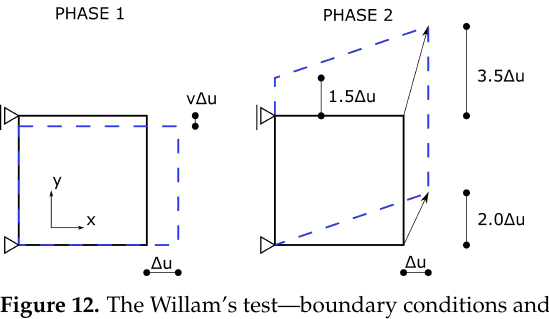
Figure 12. The Willam’s test—boundary conditions and coordinate system.